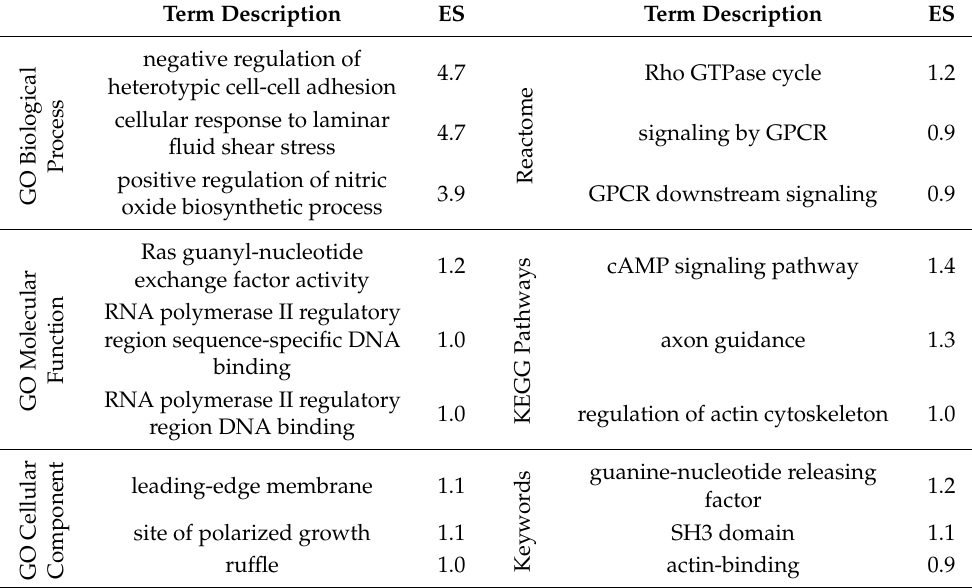
Table 1. Top three results based on the enrichment scores (ES) by STRING analysis. STRING analysis using GO terms, KEGG, and Reactome pathways as well as keywords resulted in similar enrichment terms for 3D alginate culture as the previous analysis (see also Table S4). It can be emphasized that especially terms regarding morphology and functions of plasma membranes in combination with small G-protein activity were enriched, in particular for Rho GTPase. Term Description